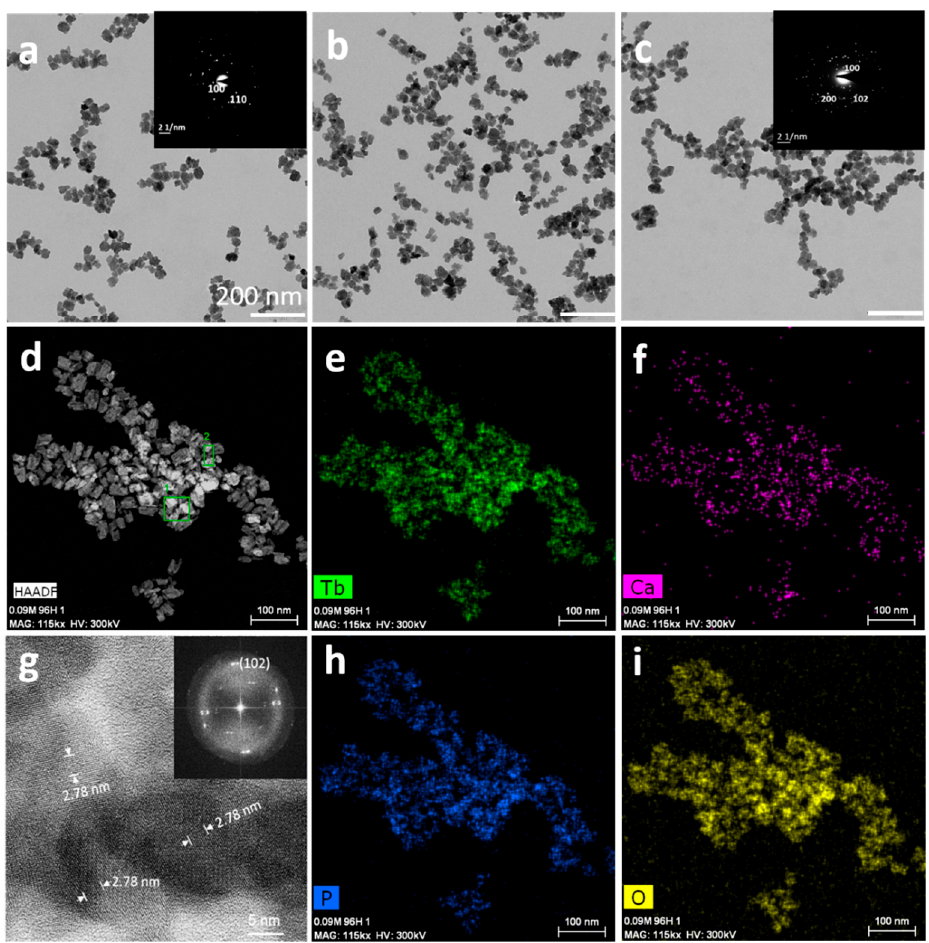
Figure 3. ( a – c ) TEM micrographs of cit-Ca 2+ :TbPO 4 ·H 2 O nanorods prepared with different Ca 2+ doping concentrations at 96 h: ( a ) x = 0.01 M; ( b ) x = 0.03 M; ( c ) x = 0.05 M. Insets display SAED patterns of the nanoparticles. ( d ) HAADF-STEM micrograph of sample x = 0.01 M Ca 2+ . ( e , f , h , i ) EDX element mapping analysis of Tb, Ca, P, and O in nanoparticles of image ( d ). ( g ) HR-TEM image showing lattice fringes and d-spacing of 2.78 Å corresponding to plane (102) of nanocrystals of sample x = 0.01 M Ca 2+ . Inset in ( g ) shows the corresponding Fourier transform (FFT) image displaying the (102) plane.